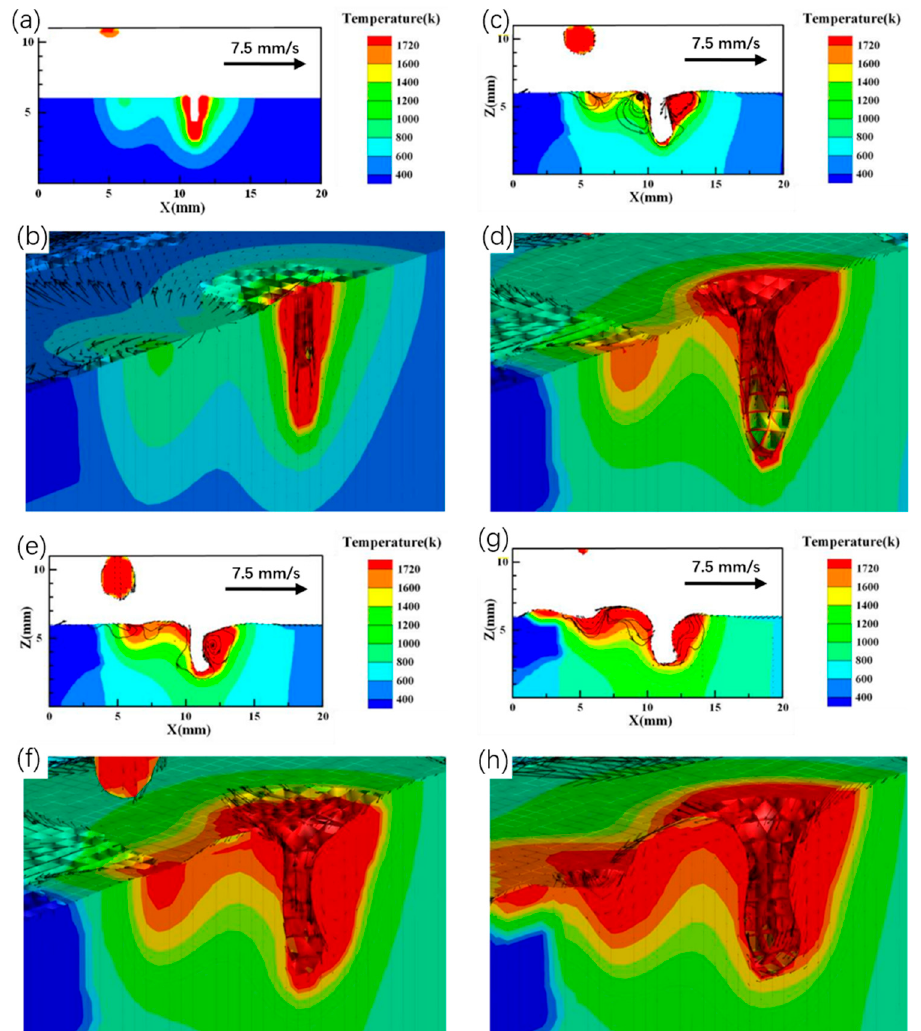
Figure 9. Temperature field distribution of the weld section and three-dimensional fluid flow diagram of the molten pool at different time: ( a , c , e , g ) are the temperature field of the weld section at 100 steps, 1000 steps, 1500 steps, and 2000 steps, respectively; ( b , d , f , h ) are the three-dimensional fluid flow diagrams of the molten pool at 100 steps, 1000 steps, 1500 steps, and 2000 steps, respectively.